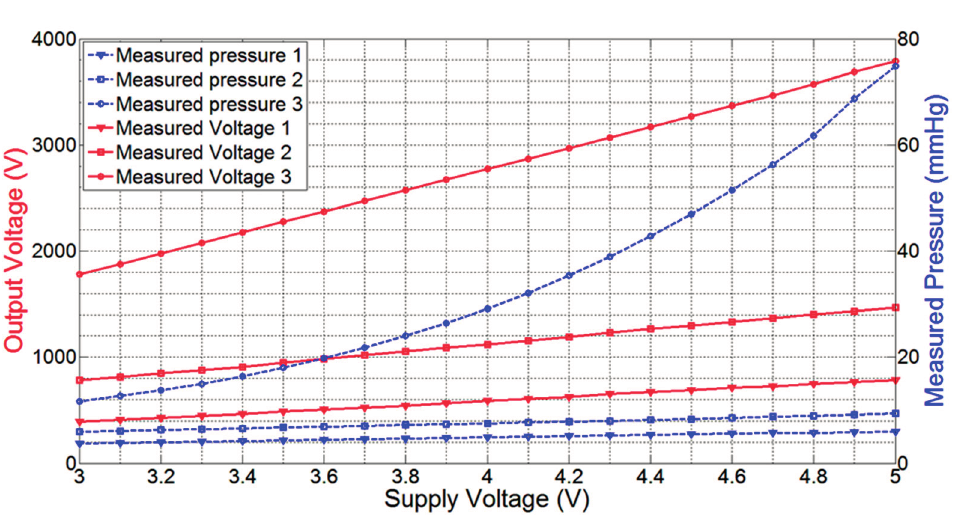
Figure 6. Graphical plot of measured output voltages of LM358 op-amp versus supply voltage, and resulting measured pressure values for three different constant pressures on the pressure